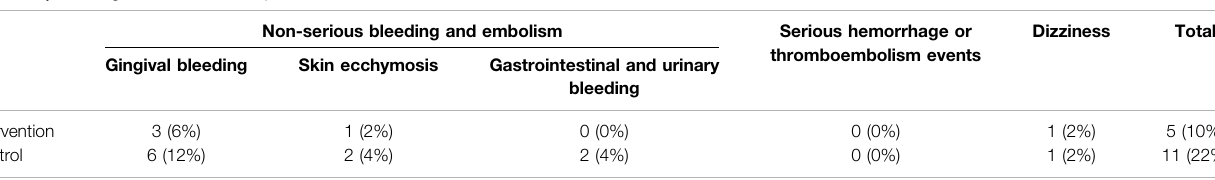
TABLE 5 | Anticoagulation-related